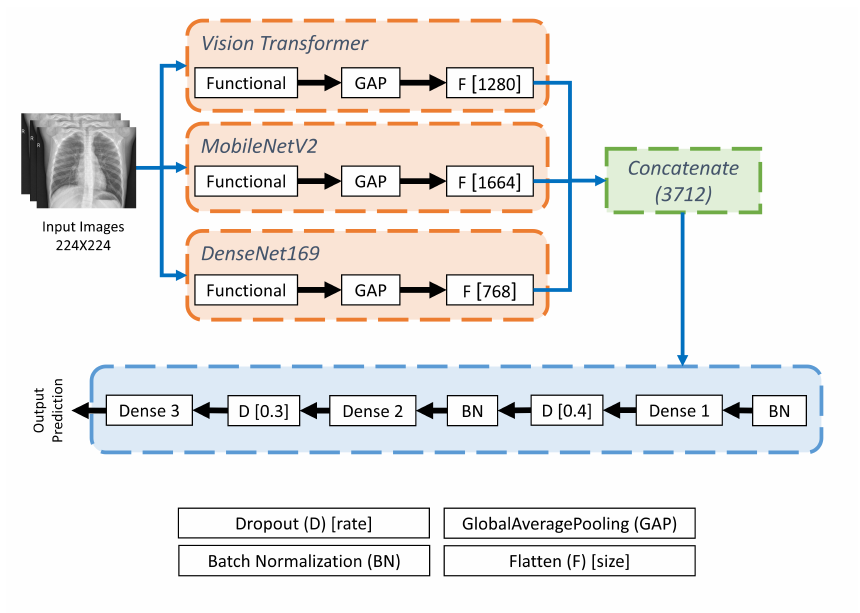
Figure 1. The structure of the proposed ensemble learning